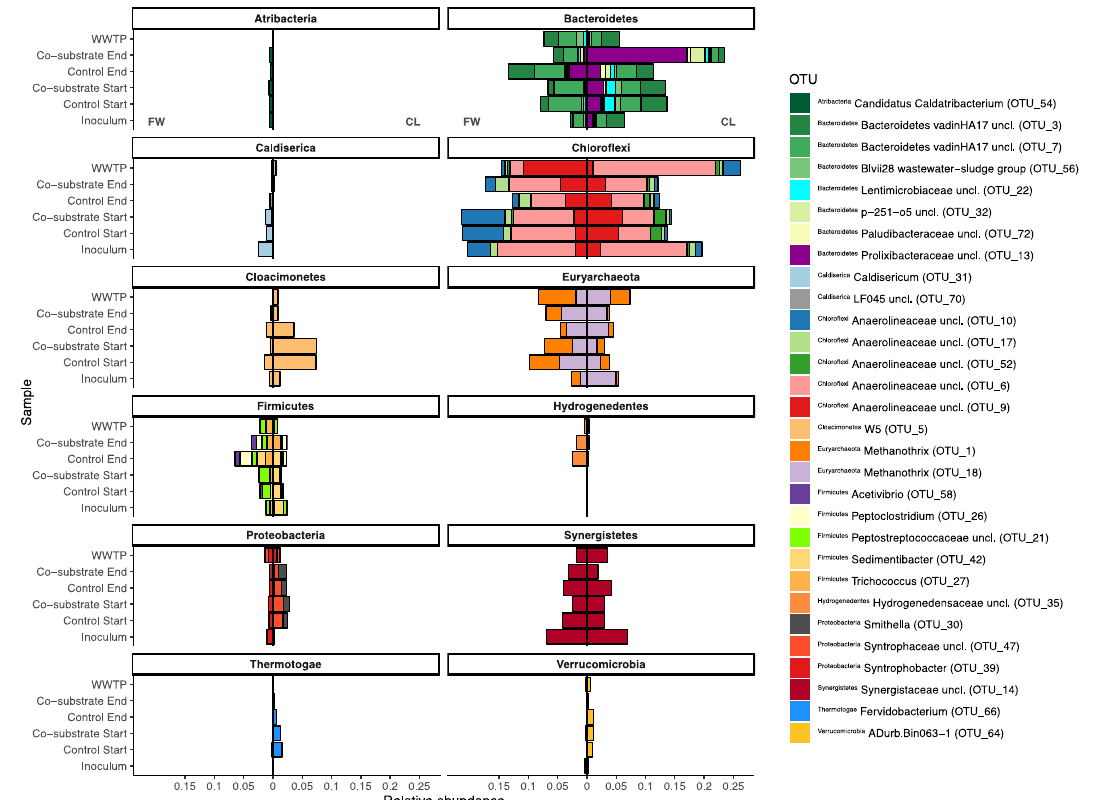
Figure 3. Divergence bar plot showing samples from the inocula, the lab-scale reactors, and the WWTP. Plotted are the OTUs with the top 30 Permanova coefficients identified as the response variables when “Experiment” was chosen as the independent categorical factor and MCC as the response variable (see also Figure 4). Shown are the OTUs that have either the most positive (15, max = 0.017) or most negative (15, min = − 0.017) coefficients, thus most differentiating the two MCCs from each other. Bars are plotted phylum-wise, with bars extending from the centerline to the left representing the relative abundance of the respective OTU in the FW experiment, and bars to the right representing the CL experiment. The WWTP sample at the top of each plot represents a WWTP sample at the end of the respective experiment, that is, approximately 100 days past the